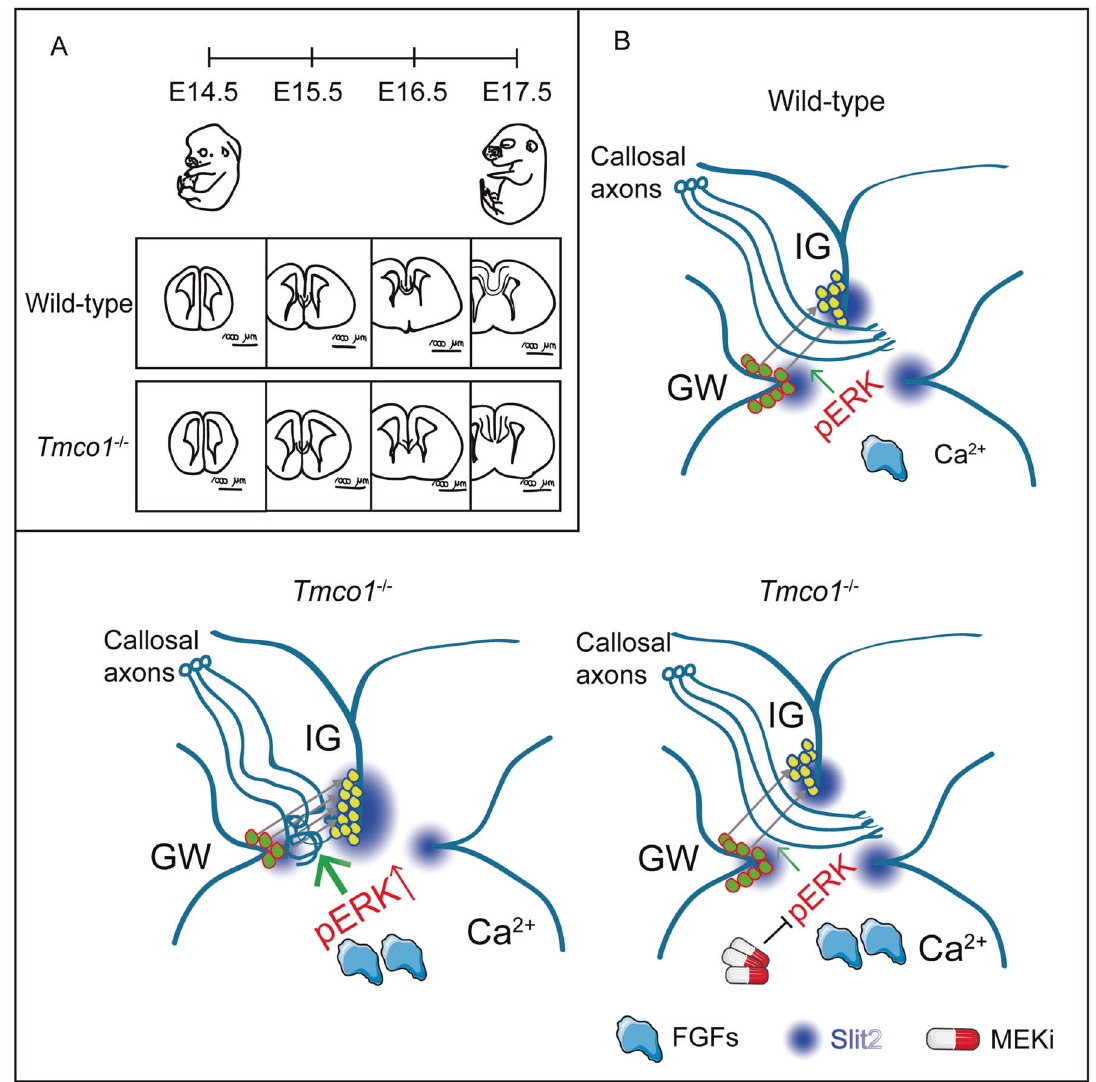
Fig. 6 Model for TMCO1 de fi ciency-induced agenesis of corpus callosum (AgCC) and MEKi-restored corpus callosum (CC) formation. A The Tmco1 − / − brains exhibit severe CC defect during E14.5-E17.5. B Compared to wild-type embryonic brains with normal CC extension ( B , upper right), the abnormal Ca 2 + homeostasis induced by TMCO1 de fi ciency leads to supernormal Ca 2 + signaling, over-activation of the FGF/ERK signaling at the midline, excessive migration of glial cells from GW to IG, and overpopulation of glial cells in the IG ( B , lower left). Then the robust Slit2 signals secreted by IG glial cells repulse the callosal axon navigation before crossing the midline, leading to a halted extension of callosal axons and severe AgCC ( B , lower left). Clinical MEK inhibitors ef fi ciently reduce the excessive migration of glial cells from GW to IG, rebuild the Slit2 gradient balance between GW to IG, and restore the normal CC extension across the midline in Tmco1 − / − brains (lower right). These fi ndings highlight a novel role of Ca 2 + homeostasis maintained by TMCO1 in orchestrating the midline glial structure and CC formation during embryonic neurodevelopment, and provide a promising prevention strategy to relieve the related AgCC in reverse transcribed with GoStriptTM Reverse Transcription System (Promega, A5001, Madison, WI, USA). Quantitative real-time PCR reactions